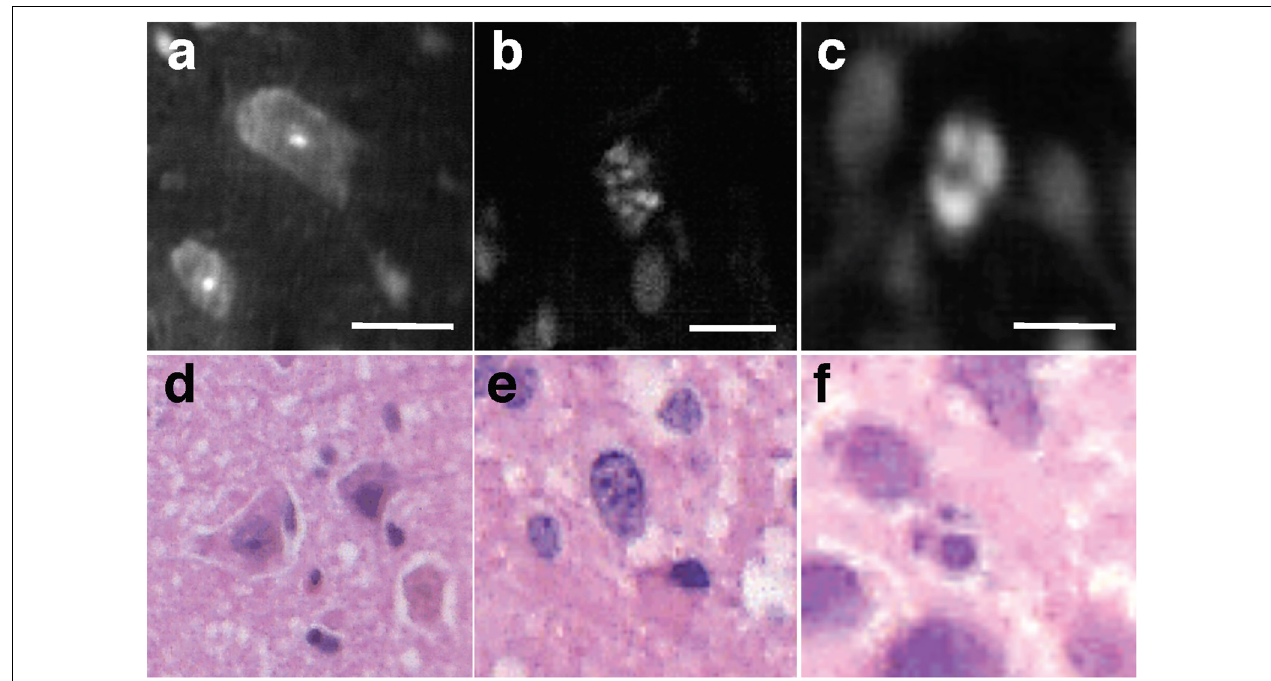
FIGURE 5 | Subnuclear features. Examples of LS-DAC images showing normal neurons (a) , and subcellular features with different chromatin patterns (b,c) in human gliomas (topically stained with acridine orange), along with corresponding H&E histology (d–f) . Scale bars represent 10 µ m. LS-DAC, line-scanned dual-axis confocal; H&E, hematoxylin and